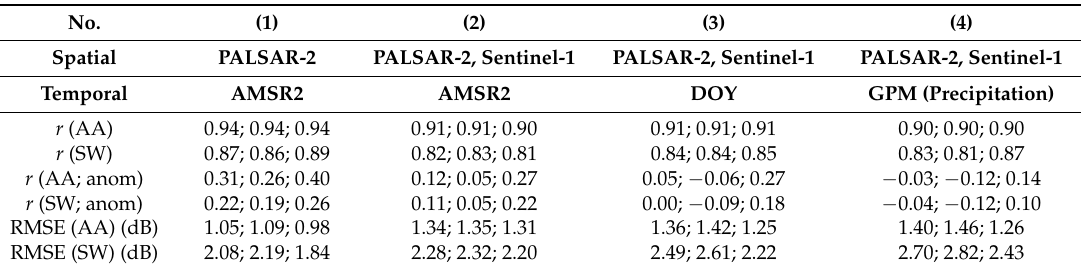
Table 3. Comparison of averaged cross-validation result (for all of the data, for the rainy season, and for the dry season) among the original and experimental RFDBUX. (1) Original RFDBUX, (2) integrated use of Sentinel-1, (3) use of DOY instead of Advanced Microwave Scanning Radiometer 2 (AMSR2), and (4) use of GPM (precipitation) instead of AMSR2. The abbreviation of the accuracy criteria is the same as in Table 2.